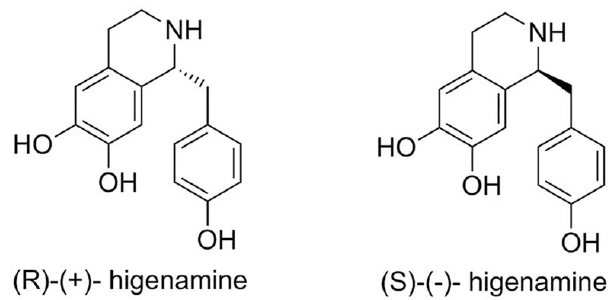
Figure 3. S -(-)-higenamine and R -(+)-higenamine structures. For the first time the compound was isolated from aconite roots ( Aconitum japonicum ;